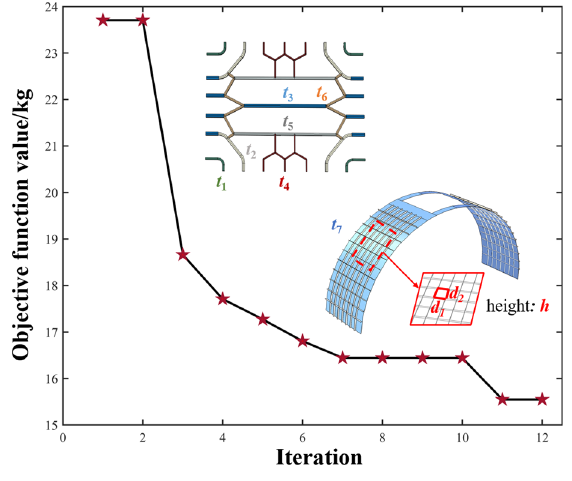
Figure 9. Iteration histories of parameter optimization based on ES-CMA-ES. Table 2. The upper and lower bounds of parameters and their optimal result.